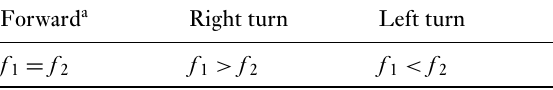
Figure 4 Driving electric voltage. Table 1 Moving motion of the micro-robot